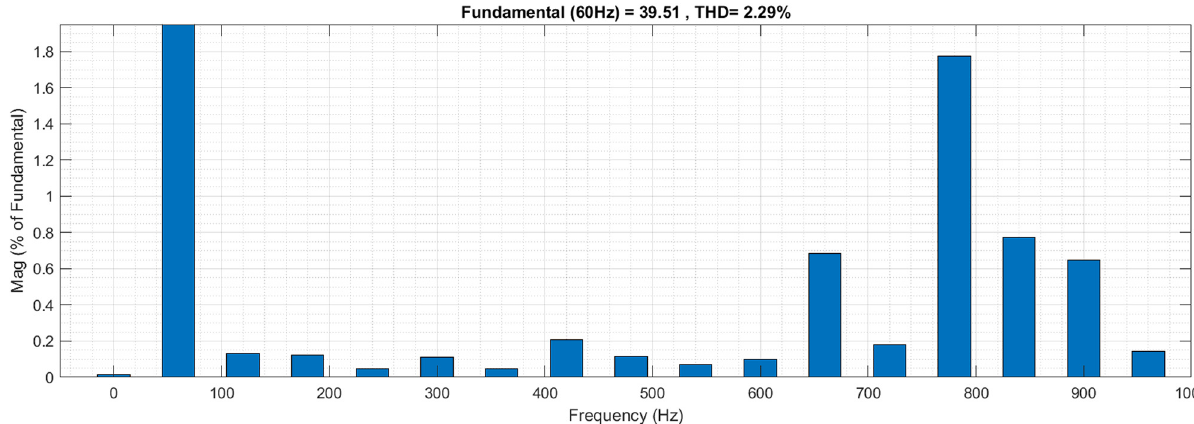
Figure 7: e abc THD. Scenario 1 – connection to a balanced power